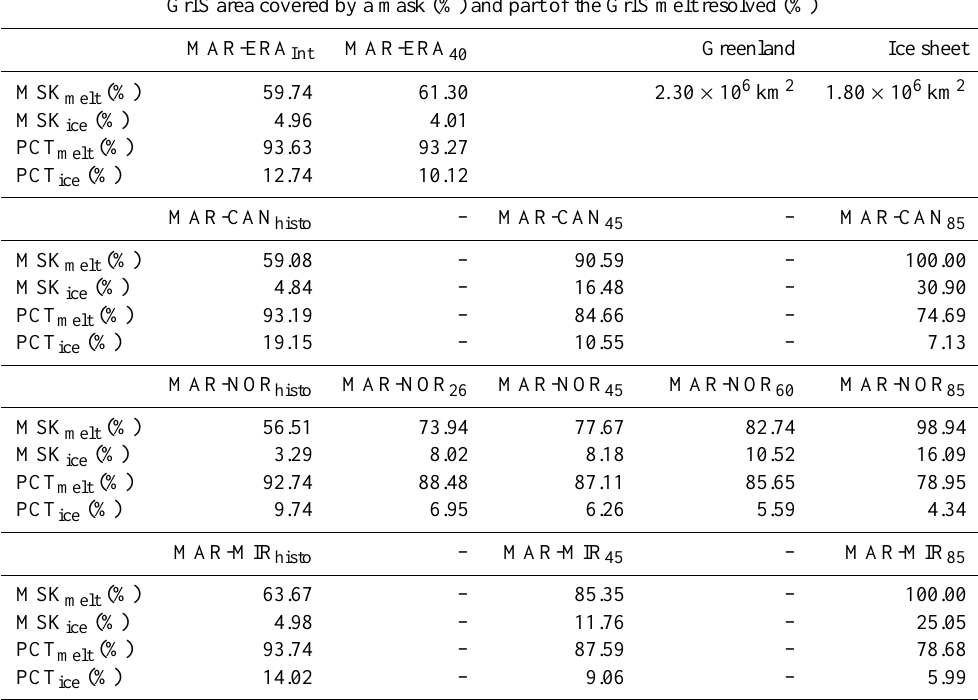
Table 2. Part (in %) of the GrIS area covered by the maximum extent of MSK melt and MSK ice , and percentage of the total GrIS melt resolved by the 1980–1999 mask (PCT melt and PCT ice , respectively), according to the forcing fields of the MAR model. MSK melt and MSK ice have been implemented over the 1980–1999 period for the present-day simulations, and over the 2080–2099 period for the future projections. PCT melt and PCT ice have been calculated on the basis of the 1980–1999 MSK melt and MSK ice , respectively. GrIS area covered by a mask (%) and part of the GrIS melt resolved